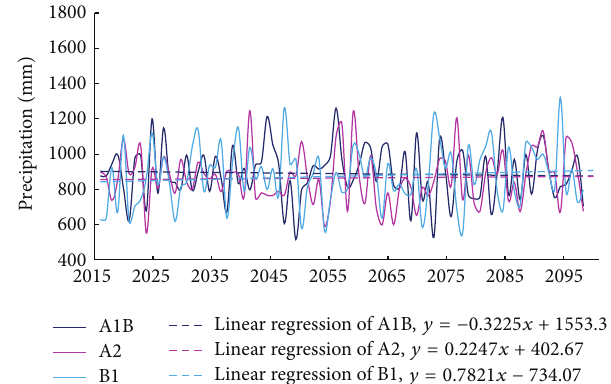
Figure 7: Annual precipitation changes from 2016 to 2100 under three climate change scenarios.